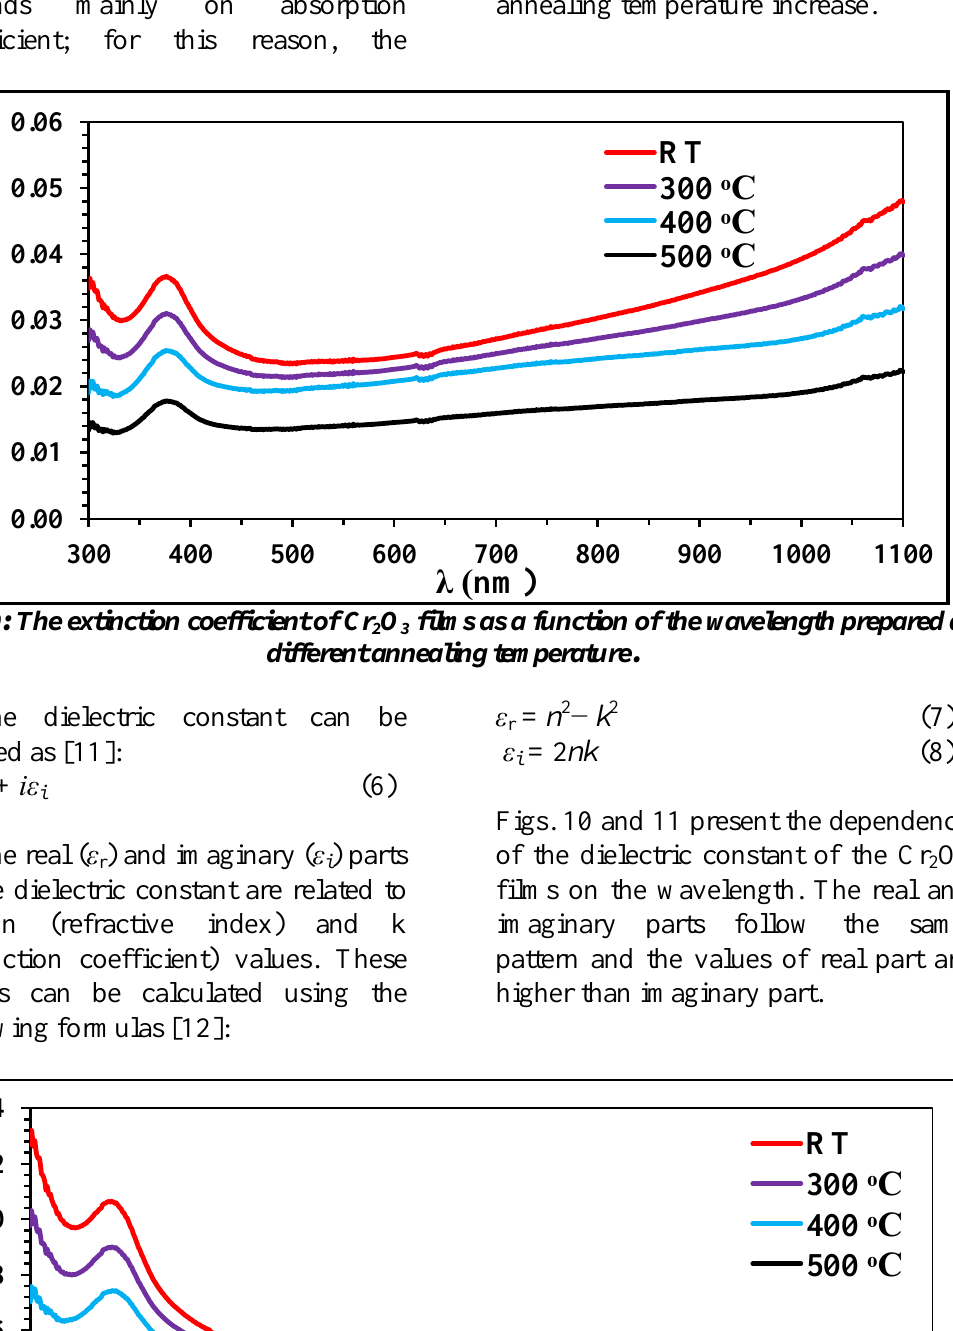
O films as a function of 2 3